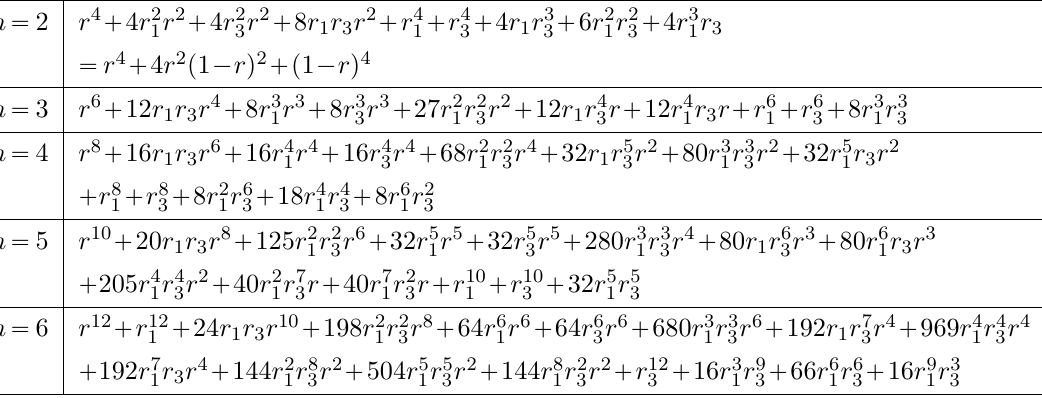
p r 1 ;r 3 qq for k (cid:16) 2. n